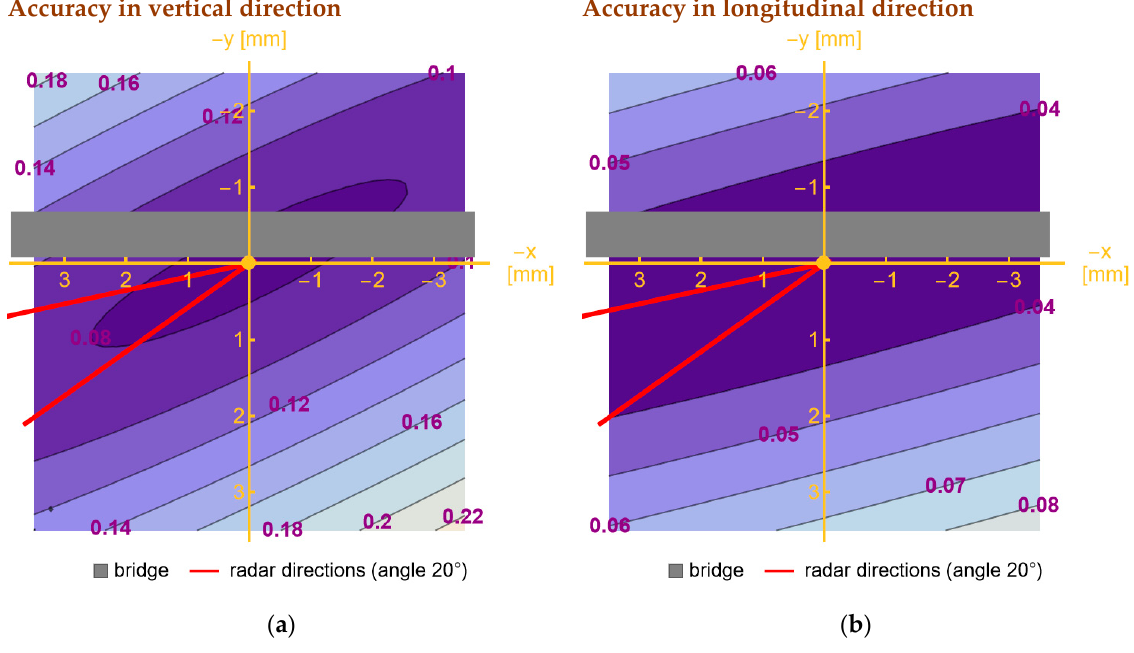
Figure 9. Standard deviations when the radars are located behind each other (vertical angles of radar directions are 10 ◦ and 30 ◦ ). The angles are determined with precision 0.5 ◦ . Standard deviation of measured LOS displacement is 0.02 mm. Numeric values on the axes and on the isolines are in mm: ( a ) Standard deviation σ y ; ( b ) Standard deviation σ x